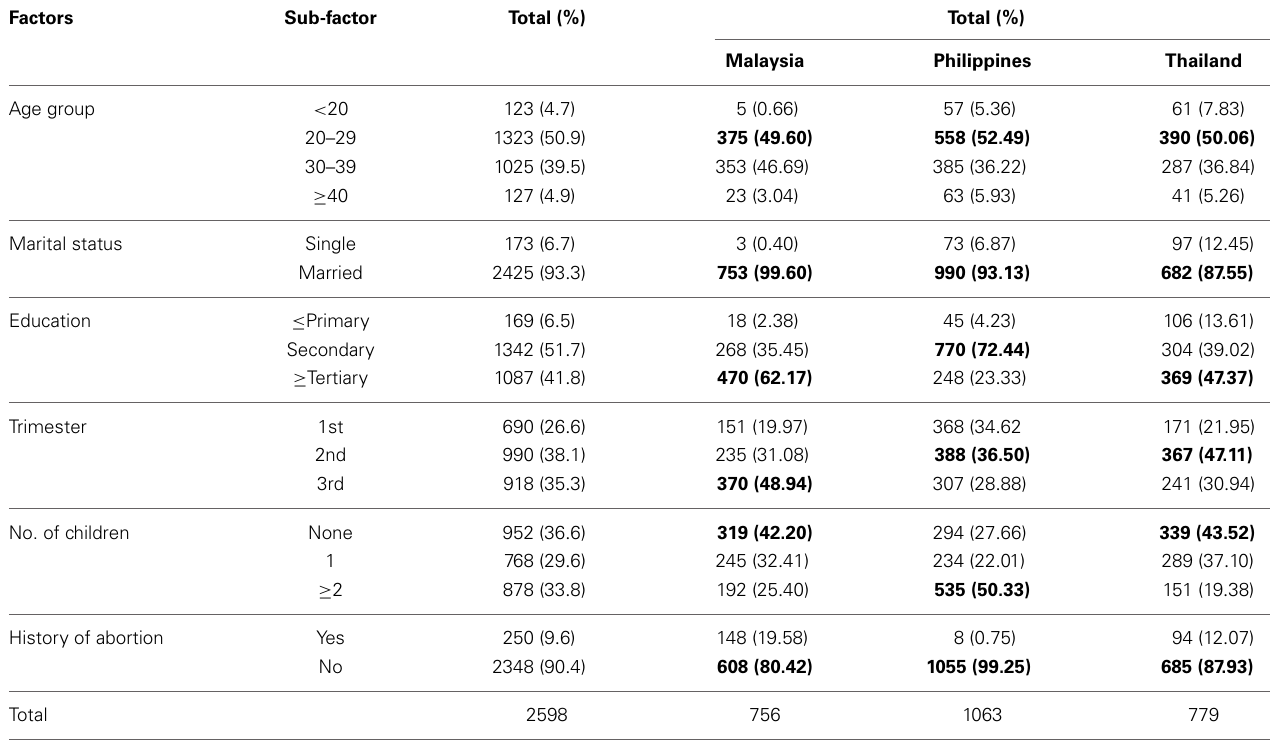
Table 1 | Demographic profiles of the pregnant